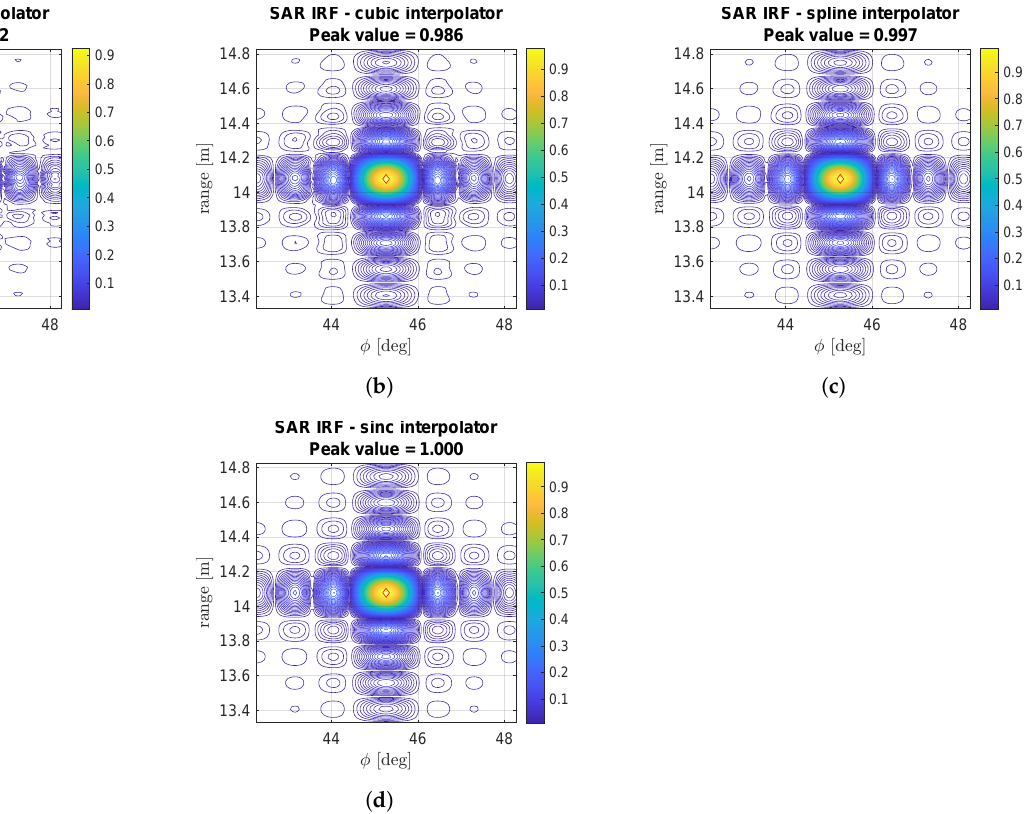
Figure 9. A s = 18 cm. SAR Impulse Response Function (IRF) generated by direct TDBP on a very fine polar grid centered in the nominal position of the target. The higher the order of the interpolator, the better the image in terms of peak value and side lobes. In Figure 10, the FFBP has been tested using different interpolation kernels. In addition, in this case, the quality depends on the interpolation kernel used. The higher the degree of the interpolator, the better the image. The spline interpolator reaches practically the same accuracy of the direct TDBP.